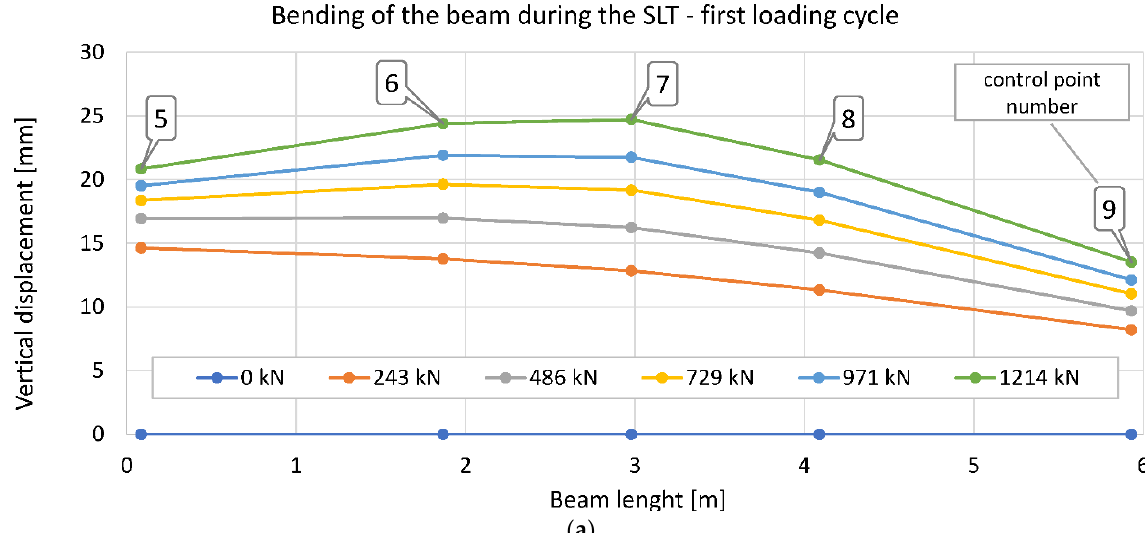
Figure 9. Vertical displacement of check points: 1 = left anchor pile, 2 and 3 = loaded pile, and 4= right anchor pile.